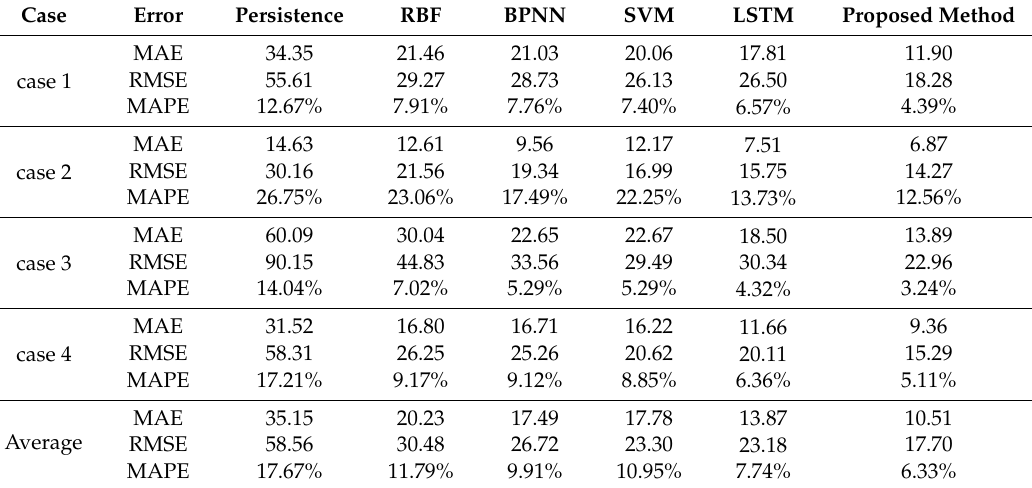
Table 2. Performance evaluation for the 30-min ahead